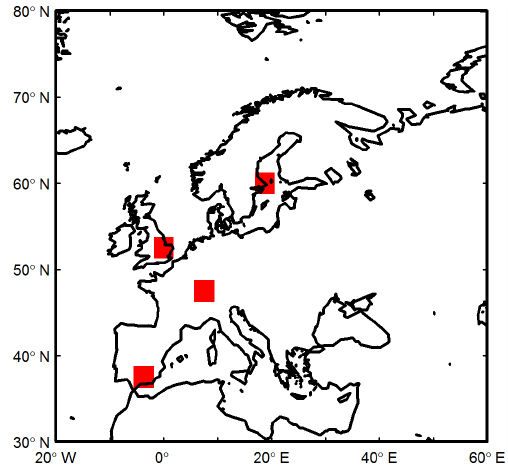
Figure 13. Map of Europe highlighting the grid boxes that repre- sent the four case study sites. From north to south: Sweden, central England, Switzerland and